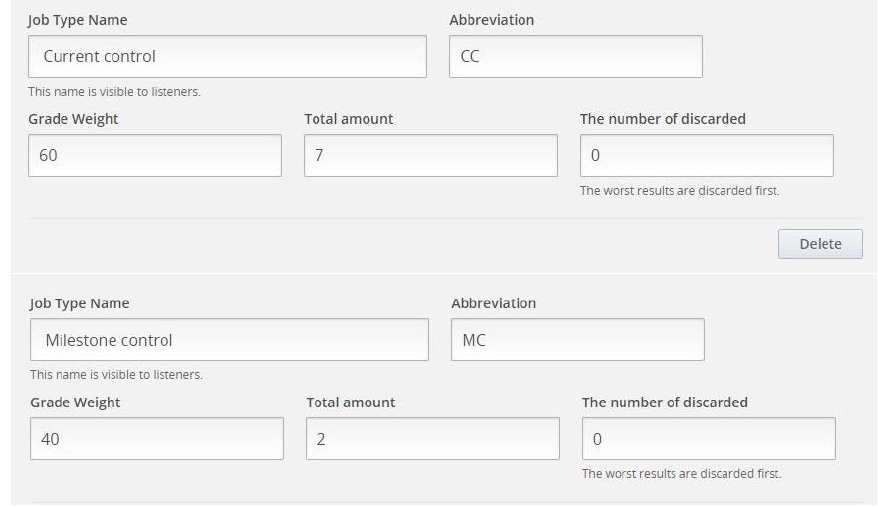
Fig. 3. Weighting coefficients of various types of